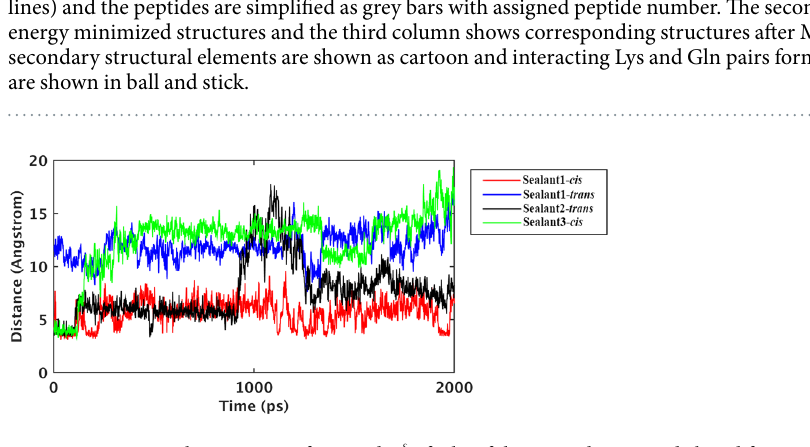
Figure 6. Distance between N ε of Lys and C δ of Gln of the second isopeptide bond forming site for the dimers having following special arrangements: sealant 1- cis (red), sealant 1- trans (blue), sealant 2- trans (black) and sealant 3- cis (green) for 2ns simulation, having one prior isopeptide